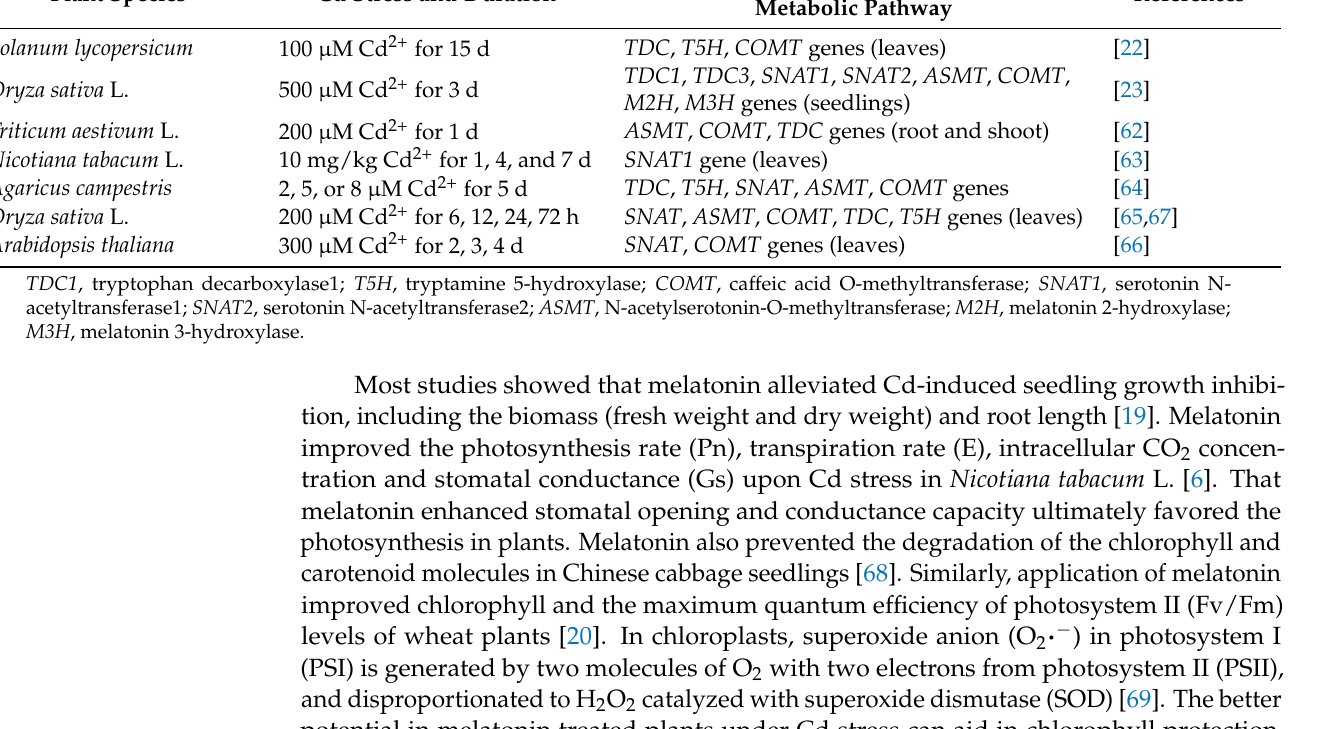
Impact on Genes Related to Melatonin Metabolic